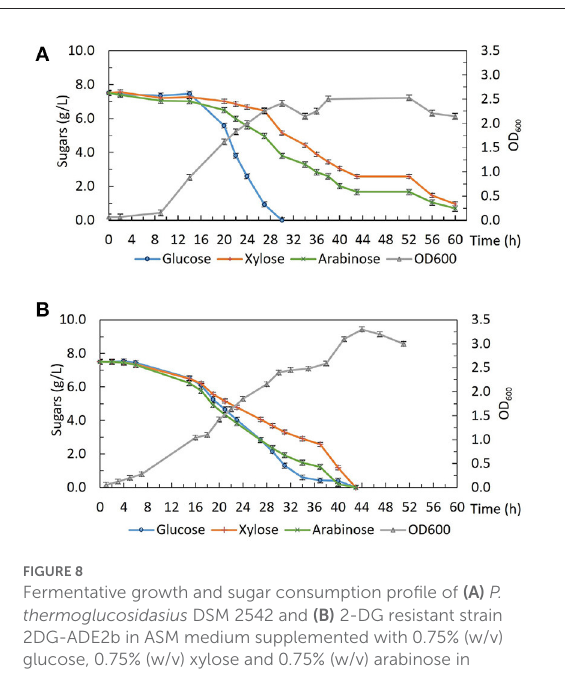
FIGURE8 Fermentative growth and sugar consumption profile of (A) P. thermoglucosidasius DSM 2542 and (B) 2-DG resistant strain 2DG-ADE2b in ASM medium supplemented with 0.75% (w/v) glucose, 0.75% (w/v) xylose and 0.75% (w/v) arabinose in bioreactors. Error bars are ± standard deviation of three replicates taken at the same time